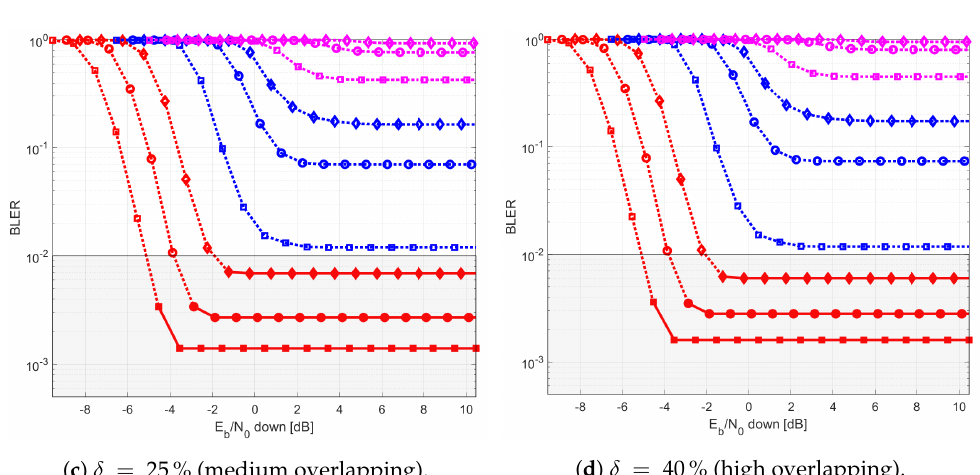
Figure 18. End-to-end BLER versus E b / N 0 in the access link for a NB-IoT frame transmitted over a regenerative satellite (Decode-and-forward) (SNR fl = 15dB). NB-IoT code rates: 0.2222 (red square), 0.259 (red circle), 0.3 (red diamond), 0.444 (blue square), 0.5319 (blue circle), 0.6 (blue diamond), 0.6386 magenta square), 0.7678 (magenta circle) and 0.8628 (magenta diamond). Solid (dashed-) lines with (un)filled markers: BLER ≤ 10 − 2 requirement (not) fulfilled. Wind speed: v = 21m/s. Diameter of telescope aperture: W 0 = 10